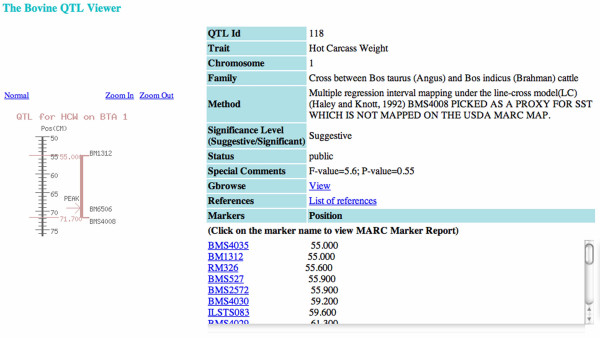
Detailed view of QTL. The critical interval of the QTL is shown along with peak marker location. QTL summary data such as QTL ID, statistical signficance, family structure and statistical methods are presented. Links to the USDA marker database are provided, along with links to references used. When a fully functional genome browser becomes available a link to that site will be provided here.